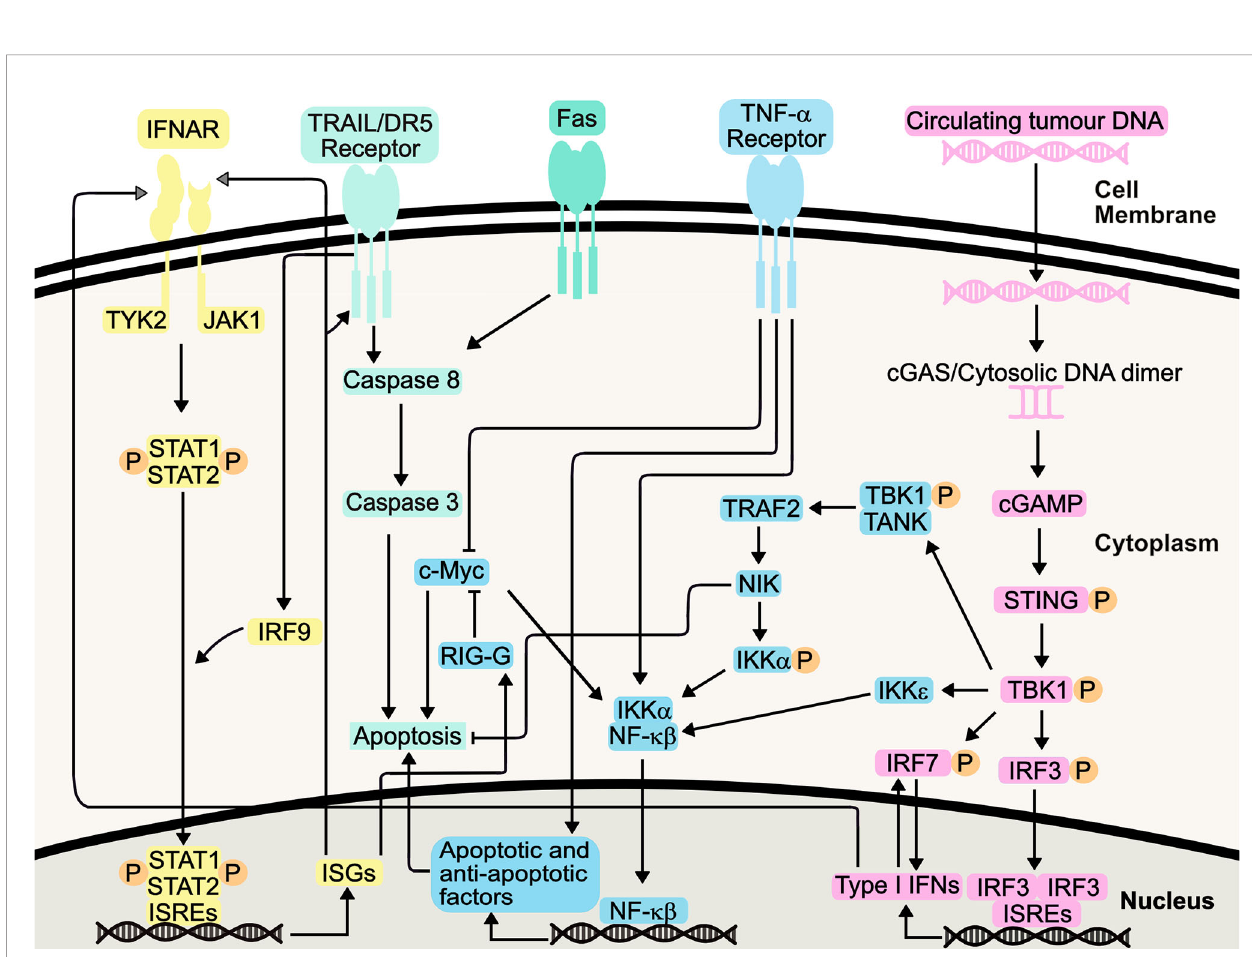
FIGURE 1 | Type I Interferon Signalling Pathways. Type I IFNs bind the IFNAR1/IFNAR2 receptors, causing heterodimerization and TYK2 and JAK1 activation, initiating STAT1/STAT2 heterodimerization and phosphorylation. Following IRF-9-mediated translocation of this heterodimer to the nucleus, it binds interferon- stimulated response elements (ISREs), resulting in transcription of interferon-stimulated genes (ISGs). Resulting proteins include death receptor ligands (including TRAIL and Fas), which bind their respective receptors. Apoptosis is induced, either directly, or indirectly via NF- kb signalling. These pathways also synergize with TNF- a pathway, increasing apoptosis. The STING pathway, initiated by detection of circulating tumour DNA, can mediate production of Type I IFNs or induce apoptosis, through canonical and non-canonical pathways following TBK1 activation. This includes its role in positive feedback loops involving IRF7, further increasing Type I IFN production.